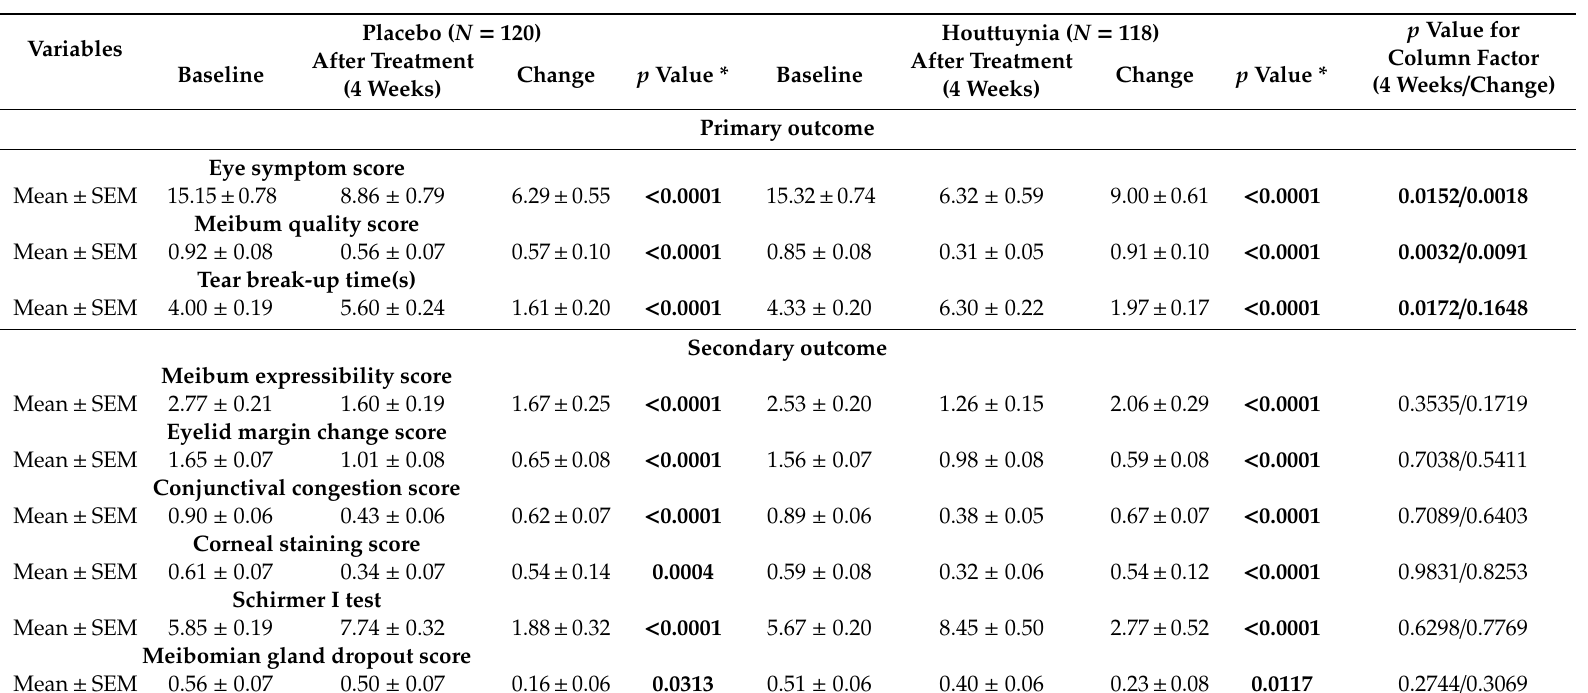
Table 1. Changes in eye symptoms and signs parameters after 4 weeks of